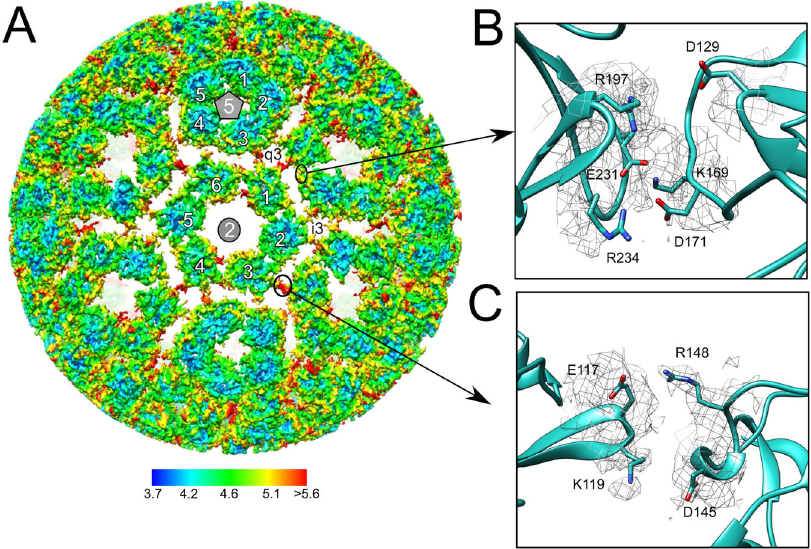
Fig. 8 Organization of the MAYV capsid. A MAYV density map showing the C-protein layer of hexameric and pentameric units coloured by local resolution estimated at a conservative FSC 0.5 threshold. The inset shows the putative electrostatic interactions between the C proteins. B Potential contacts between C proteins from the same hexameric unit and C between C protein from different assembly